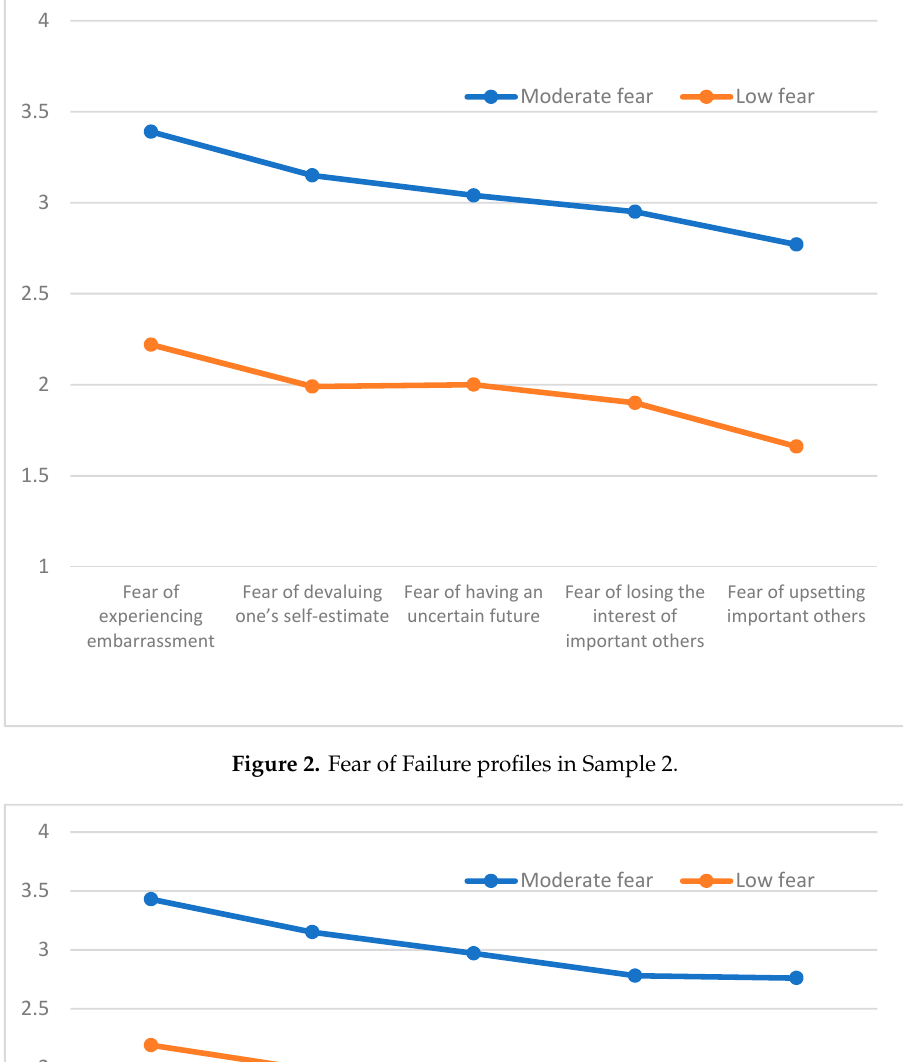
Figure 1. Profiles of Fear of Failure in Sample 1.